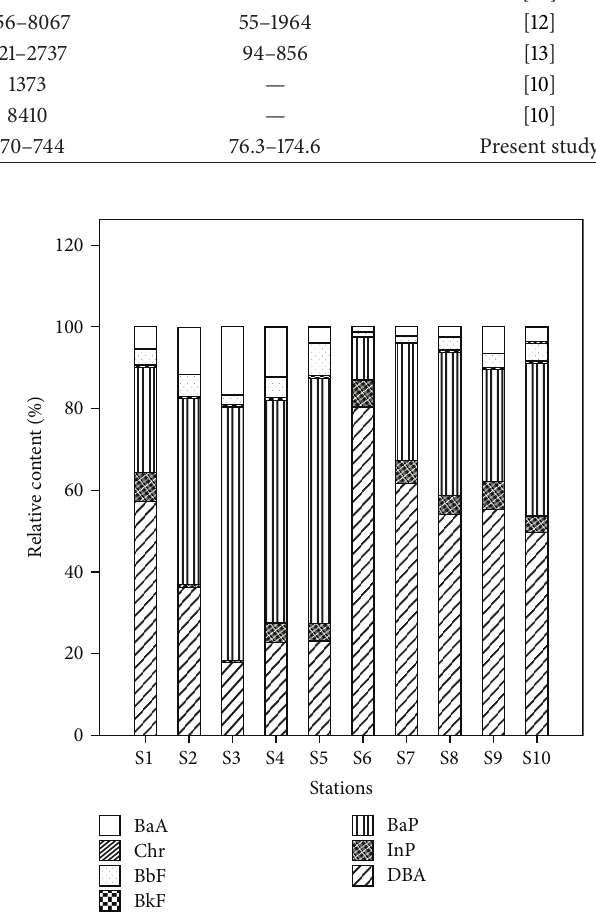
Figure 4: Relative contents of toxic BaP of potentially carcinogenic PAHs in sediments from the ten stations of Langkawi